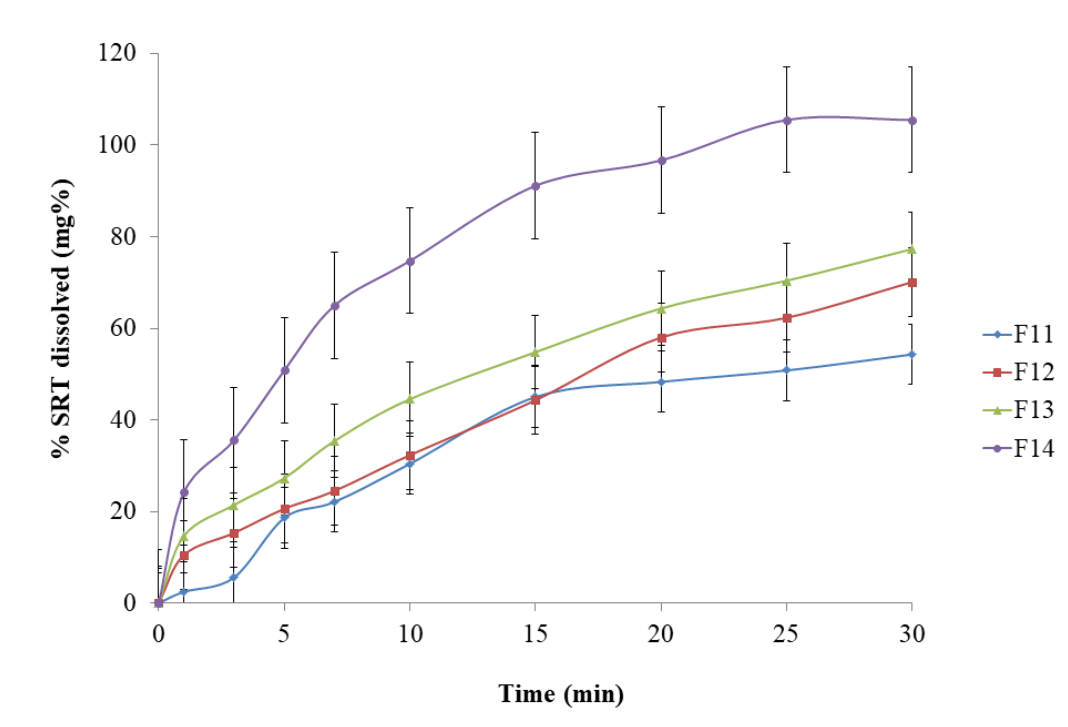
FIGURE 7 - In-vitro dissolution of SRT from the optimized SRT